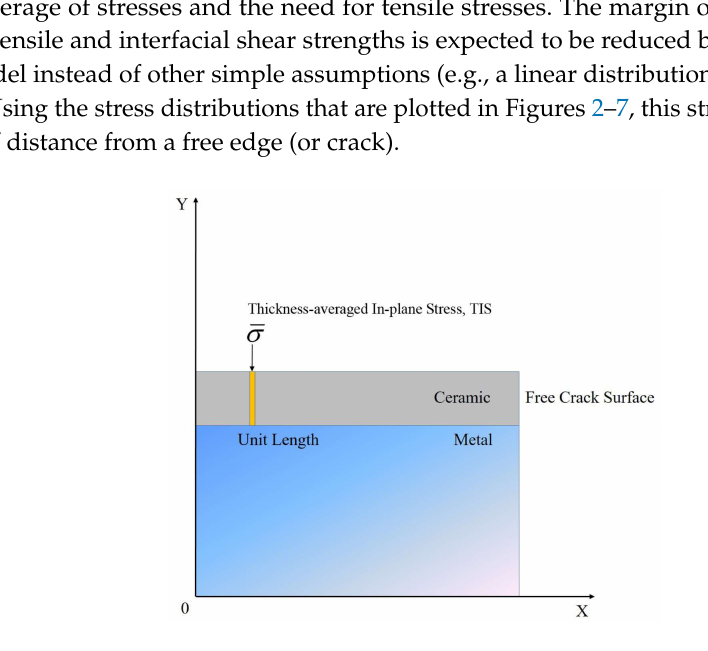
Figure 8. Schematic of the ‘Thickness-averaged In-plane Stress’ (TIS) in the film at a given x